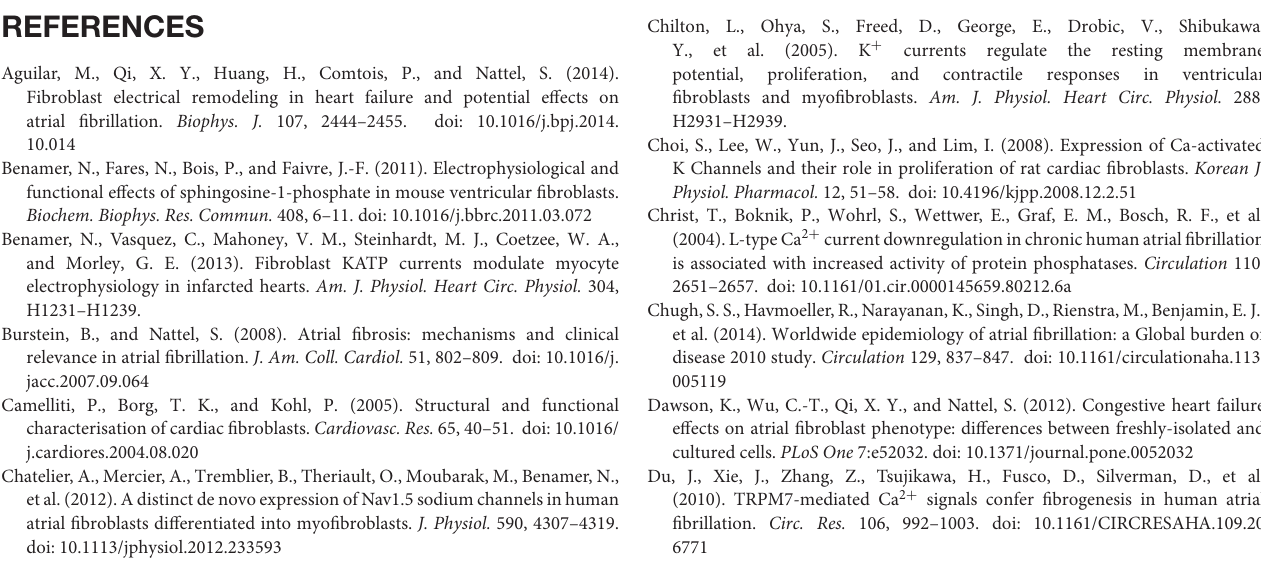
Supplementary Figure 1 | Capacitance of human atrial fibroblasts in primary culture. Capacitance of fibroblasts isolated from patients with SR and AF at passage 0 (average culture time 25 days, measured with the patch-clamp technique. Supplementary Figure 2 | KCNMA1 mRNA Expression in human atrial fibroblasts from patients with SR and AF. (A) KCNMA1 expression obtained by quantitative PCR in an immortalized cell line of human atrial fibroblasts (Künzel et al., 2020). GAPDH = glyceraldehyde-3-phosphate dehydrogenase, n = number of dishes analyzed corresponding to three independent experiments. (B) Mean KCNMA1 expression from the Affymetrix GeneChip array, performed in the study by Poulet et al. (2016) on atrial fibroblasts in primary culture isolated from patients with SR and AF, de novo analysis of original data from Poulet et al. (2016). Analysis performed after one passage (5 weeks of culture). N: number of patients; A.U.: arbitrary units. Supplementary Table 1 | Ion Currents/Channels in Cardiac Fibroblasts. CM, cardiomyocytes; FB, fibroblasts; LA, left atrium, LV, left ventricle; CHF, congestive heart failure; MI, myocardial infarction; TEA, tetraethylammonium chloride; 4-AP, 4-Aminopyridine; → : leaded to; ↑ : increase; ↓ :